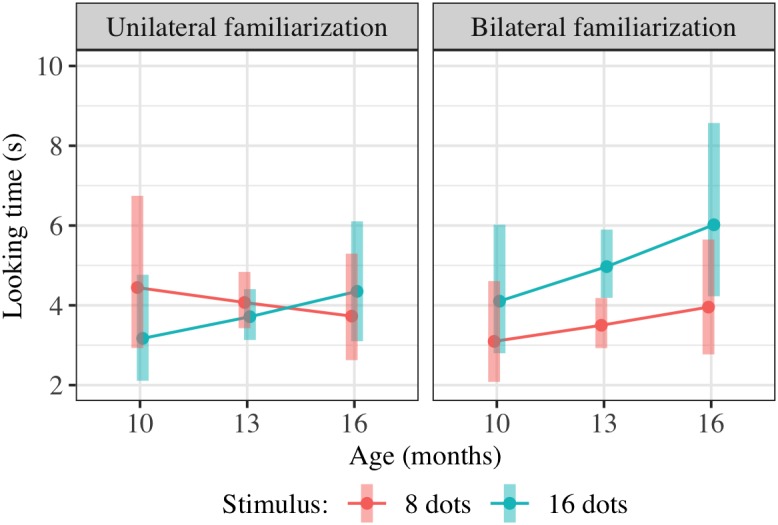
Interaction plot of estimated marginal means across combinations of familiarization condition and stimulus type over a set of reference ages spanning the tested age range, based on the linear mixed-effects model fitted for Experiment 4. Shaded error bars show 95% confidence intervals.